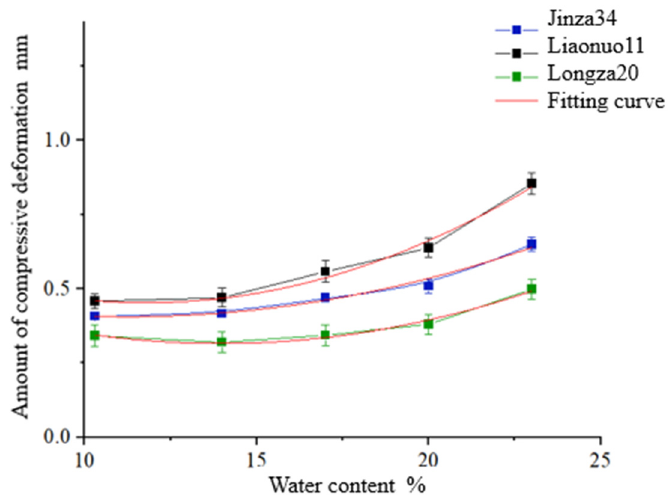
Figure 11. Compression deformation of sorghum seeds at different moisture contents.